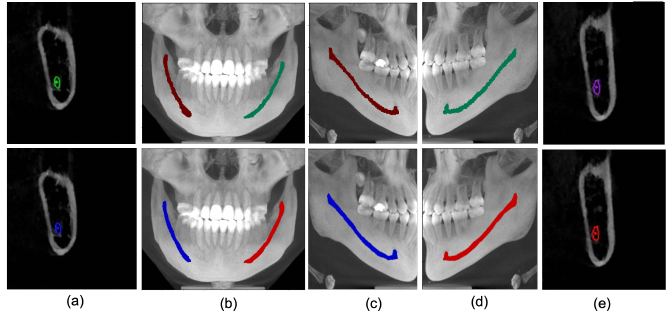
Figure 6. Ground truth (row 1) vs. Model Prediction (row 2). ( a ) Parasagittal view of right MC. ( b ) Maximum Intensity Projection of Coronal view (blue as right canal and red as left canal. ( c ) Right canal comparison with ground truth. ( d ) Left canal Comparison with ground truth. ( e ) Parasagittal view of Left